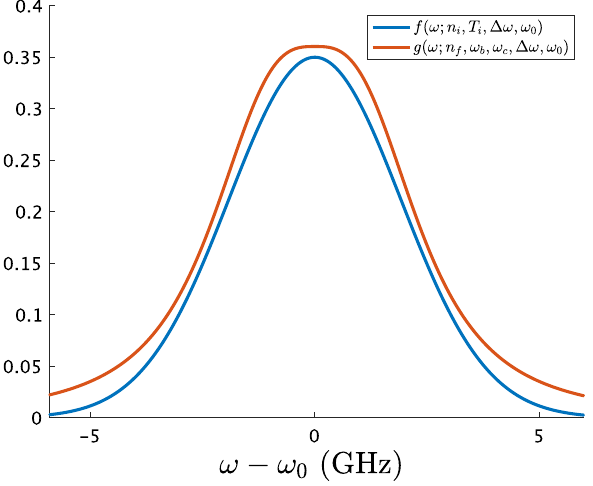
Figure 1. Comparison of the Maxwellian and slowing-down line-shapes in the absorption frequency domain. The horizontal axis represents ω − ω 0 , where ω 0 = 448.37 GHz. The Maxwellian line-shape (blue line) is plotted, where n i = 1.7 (a.u.), T i = 0.68 eV, and �ω = 0 THz. The slowing-down line-shape (red) is plotted, 7 where n f = 3.9 × 10 (a.u.), ω b = − 10 GHz, ω c = − 2.4 GHz, and �ω = 0 GHz. They correspond to